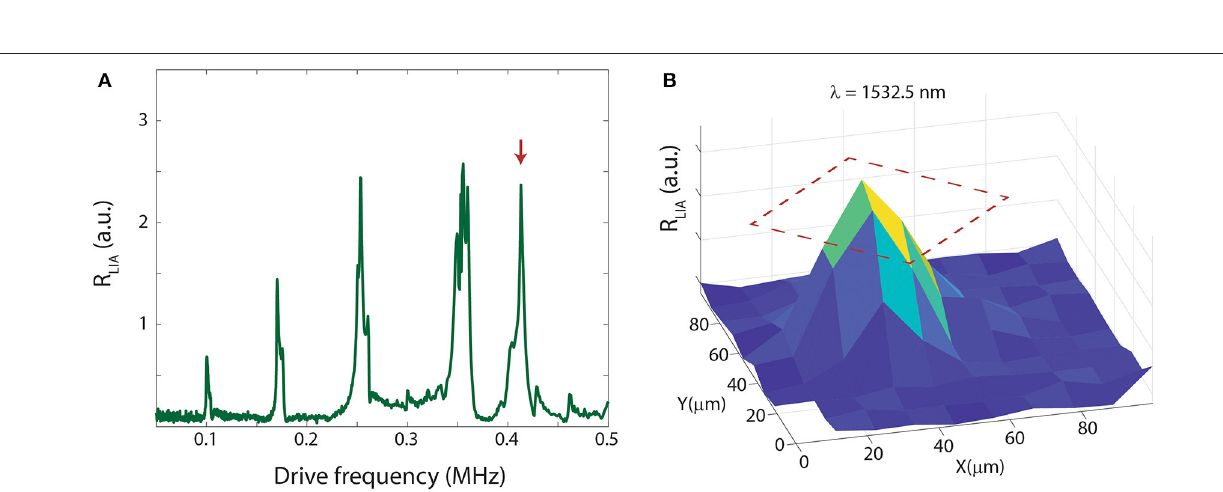
FIGURE 5 | (A) Map of the cross-polarized signal at 1,532.5nm across the membrane, whose contour is indicated as a guide for the eyes. The spectra in selected points (1–8) are individually reported. (B) Spectral evolution on the Poincaré sphere probing the point 6 of the membrane. The cross-polarized spectrum and the Poincaré plot are correlated through the plot color.